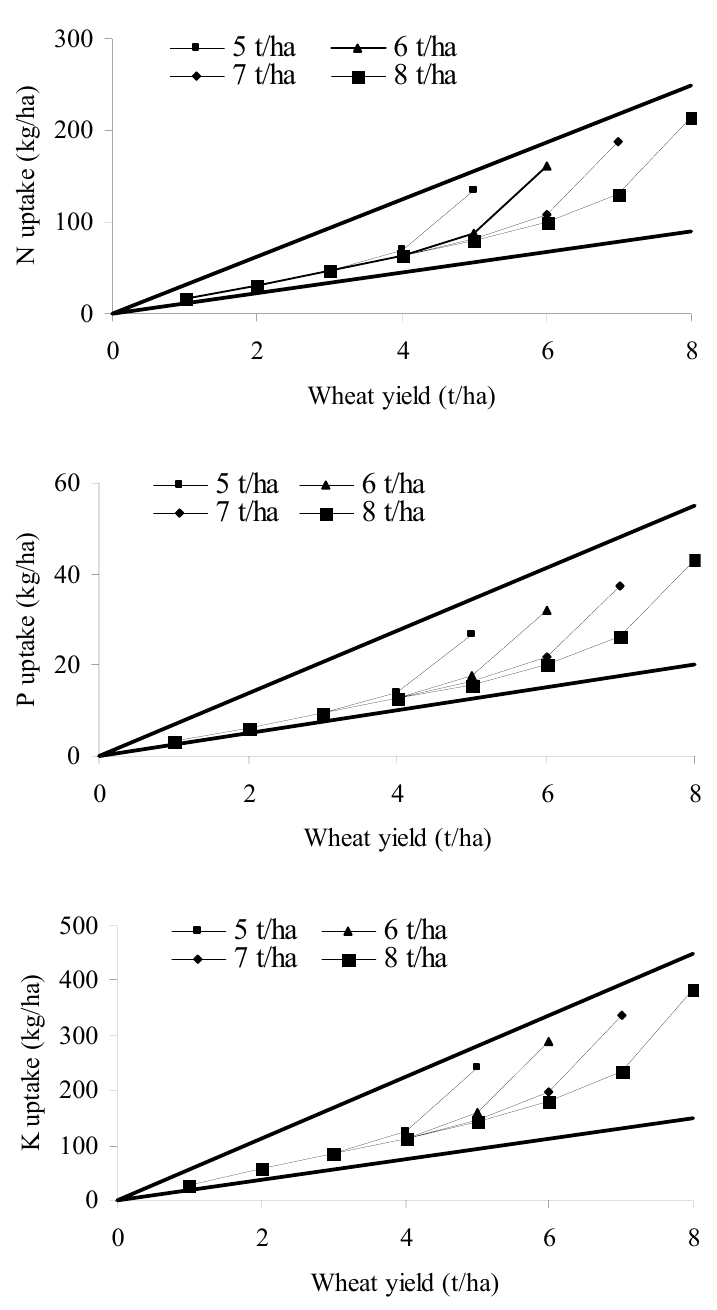
FIGURE 4. Yield of wheat in relation to plant nutrients at 5, 6, 7, and 8 t/ha potential yields. The upper and lower lines indicate yields with maximum dilution and maximum nutrient accumulation,